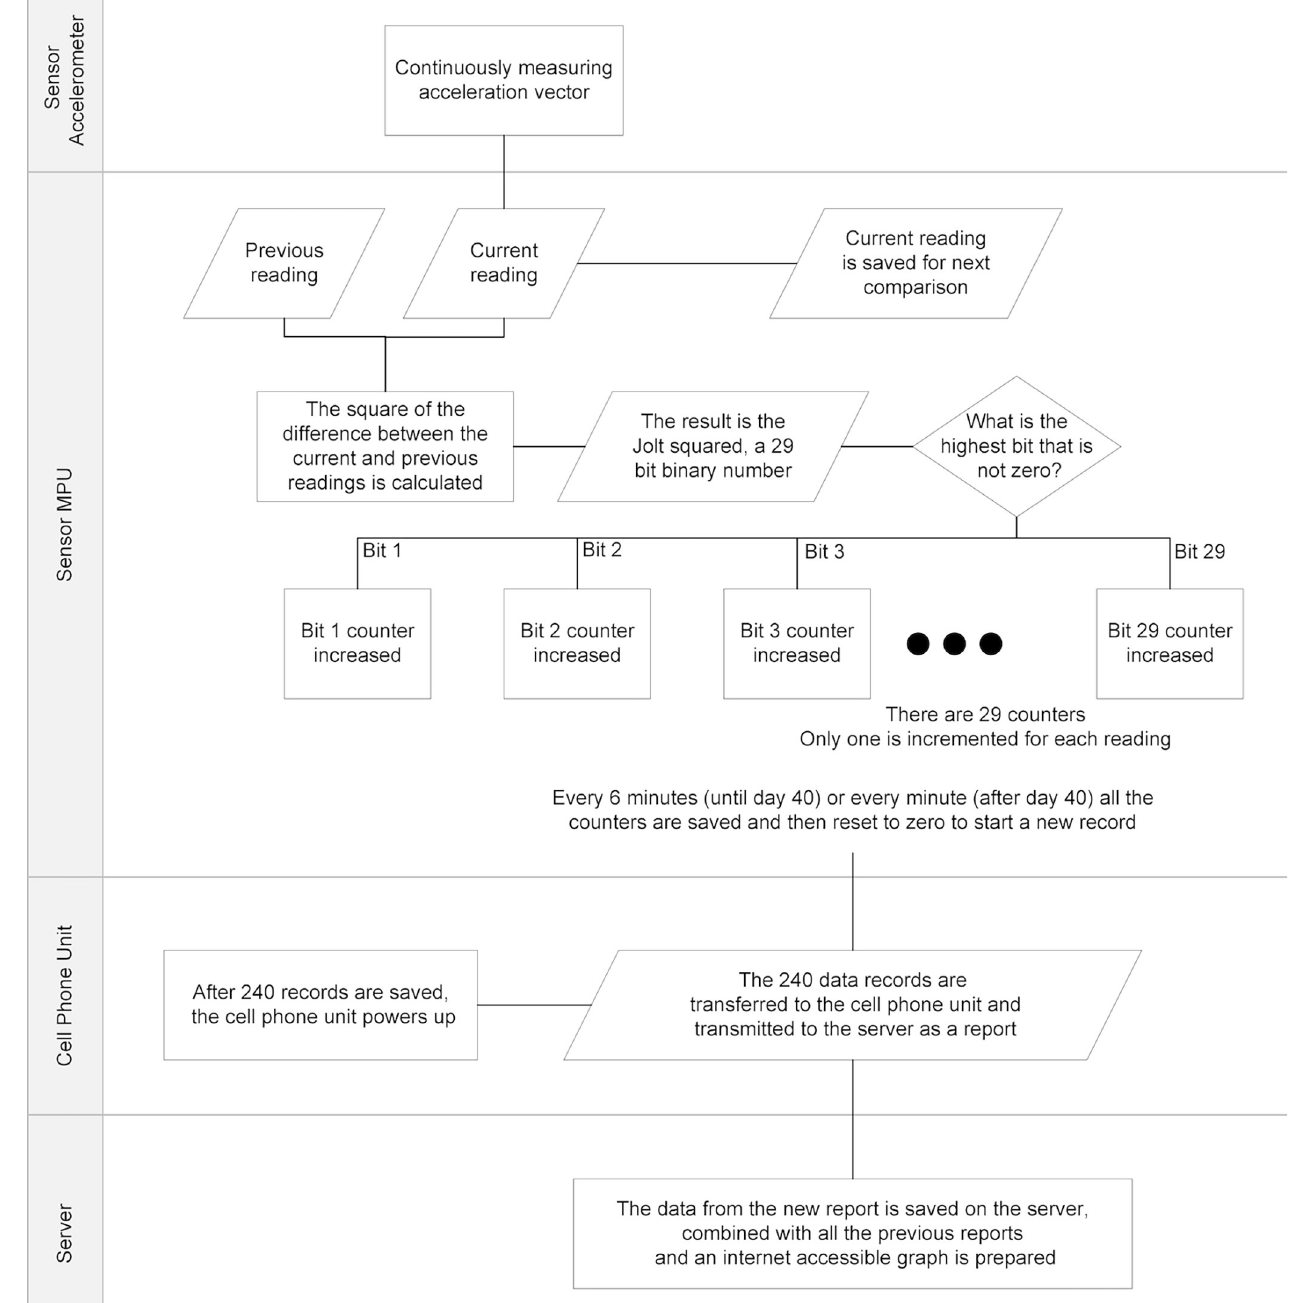
Fig 1. Schematic of data processing. A motion detector in the sensor placed in the nest constantly measures and computes changes in acceleration. The Micro Processor Unit (MPU) in the sensor counts the readings in 29 counters after sorting them by magnitude based on powers of 2. After a period of either one or six minutes, the 29 counts are stored as a record and the counters are reset. After 240 records have been created, the Cell Phone Unit is turned on and the data are sent to a dedicated server. The new data are stored, combined with the previous data, and graphed for internet access.